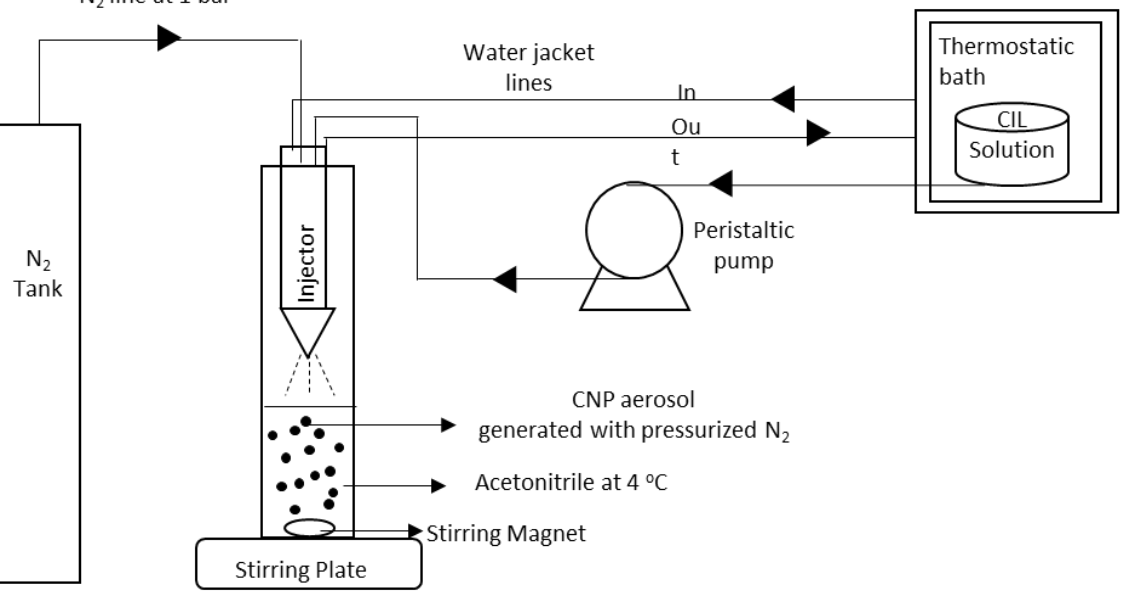
Scheme 1. Experimental apparatus used for the CNPs synthesis process.